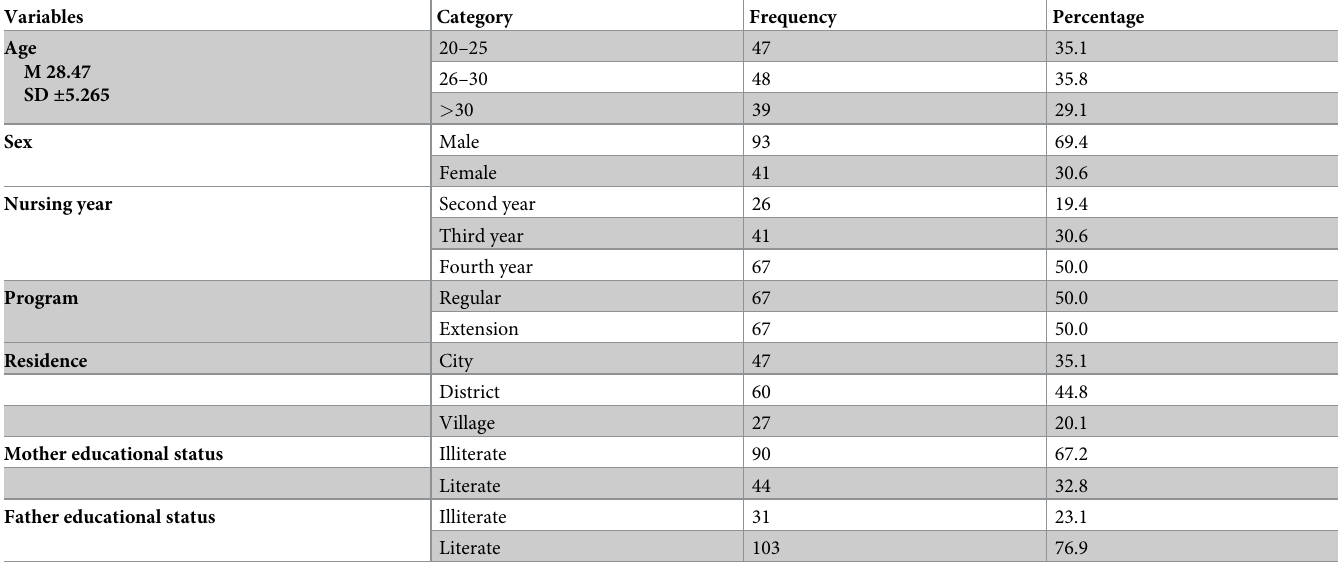
Table 1. Socio-demographic characteristics of nursing students (n =